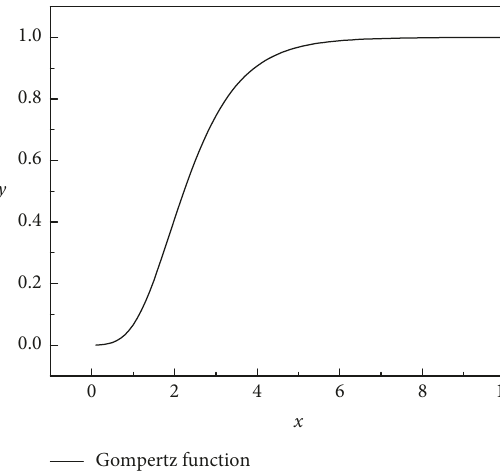
Figure 7: Gompertz function